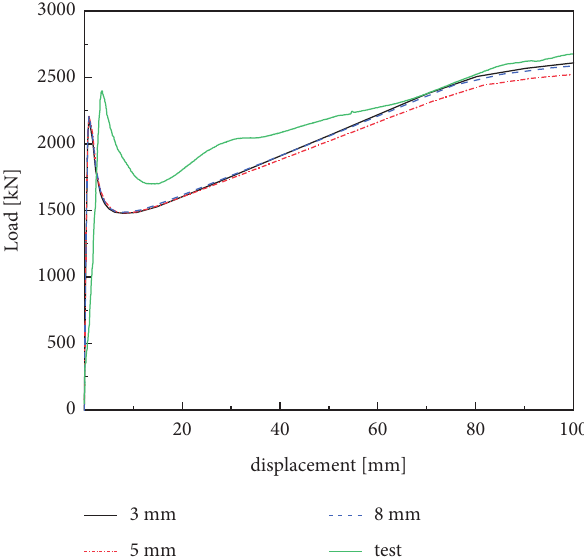
Figure 5: Load-displacement curves under different grid sizes.